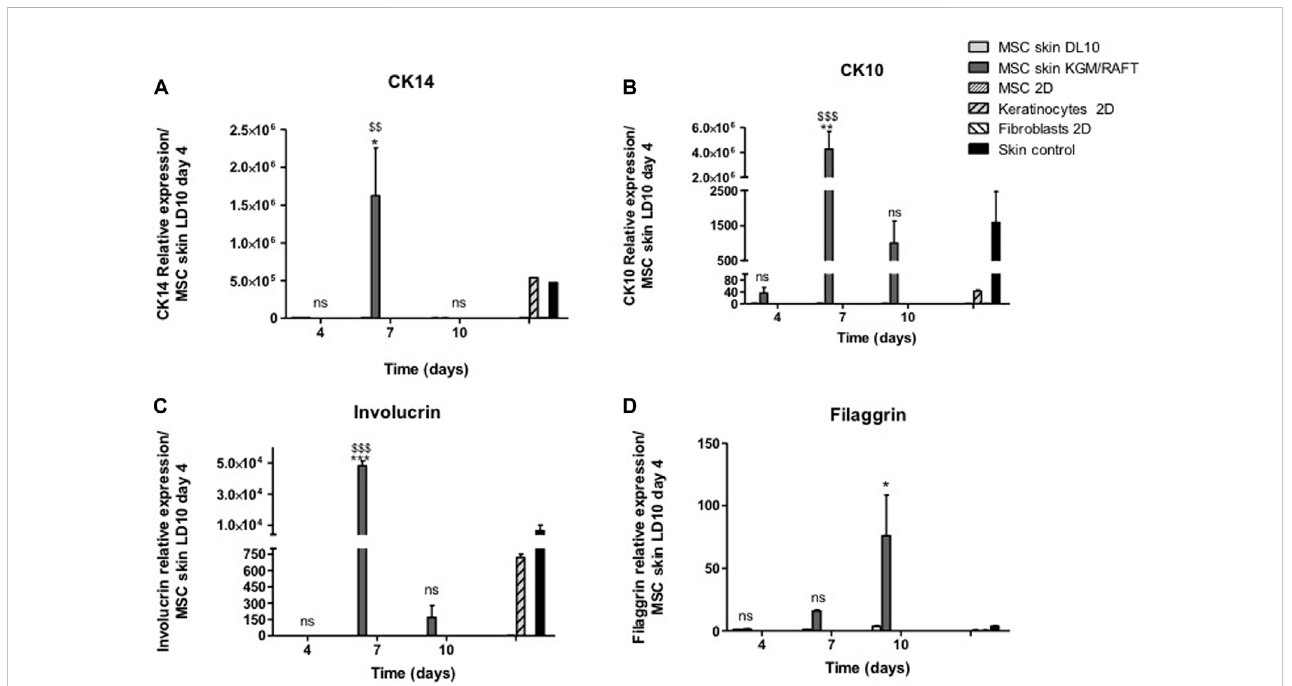
FIGURE 3 Expression of epidermal markers in the organotypic skin cultures. (A) CK14, (B) CK10, (C) involucrin, and (D) fi laggrin. MSCs were cultivated with LD10 or KGM/DM, during4,7,and10 days,ontothecollagenmatrix.MSCsand fi broblastscultured in2Dwerenegativecontrols,andkeratinocytescultured in2Dand control skin were positive controls. Data was normalized by the expression of the constitutive gene GAPDH and analyzed in relation to MSCs used as epidermal equivalent and cultivated with LD10 on the fourth day of exposure to ALI. * ( p < .05) or ** ( p < .01), different in comparison to cultivation with LD10 during the same period. $$ ( p < .01) or $$$ ( p < .001), different in comparison to MSC cultivated with LD10 at day 4; ns: not signi fi